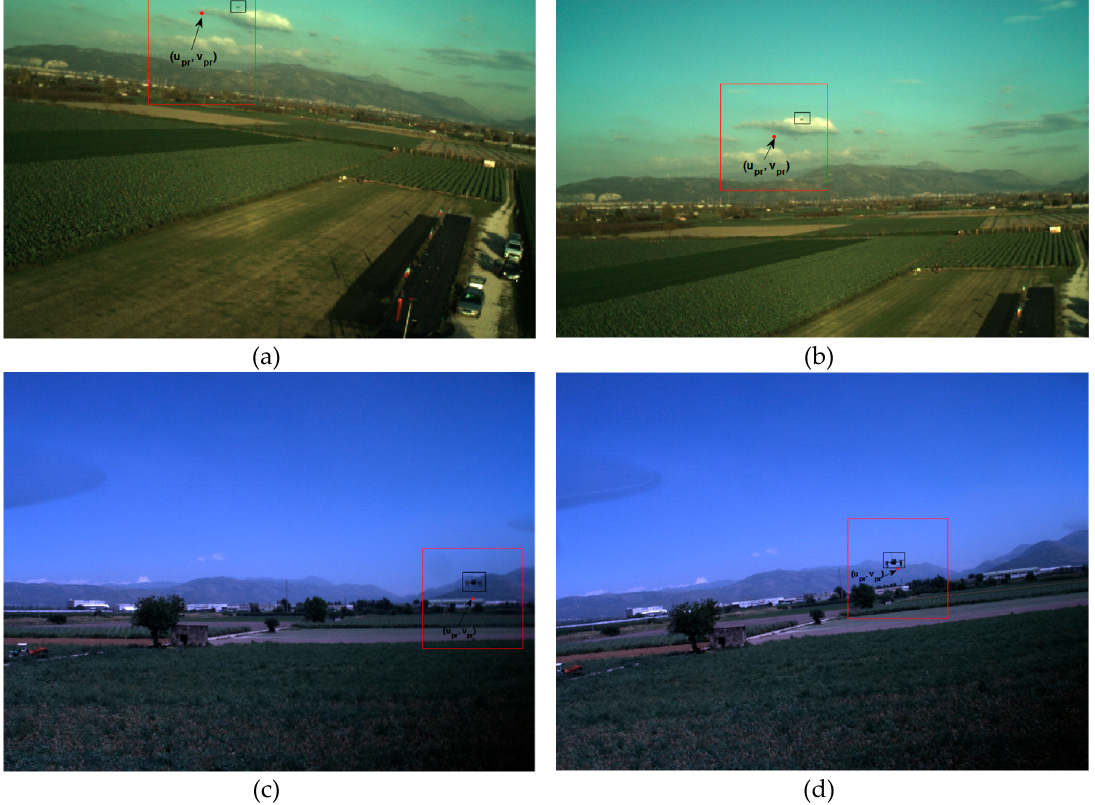
Figure 9. Examples of prediction of the target UAV projection on the image plane (highlighted by a red dot) carried out by the DL-based tracker. The search area is drawn as a red square. The target UAV is enclosed in a black box. ( a , b ) Far range scenario (target range ≈ 116 m); d u,tr = d v,tr = 150 pixels; prediction error ≈ 45 pixels. ( c , d ) Close range scenario (target range ≈ 20 m); d u,tr = d v,tr = 300 pixels; prediction error ≈ 20 pixels.